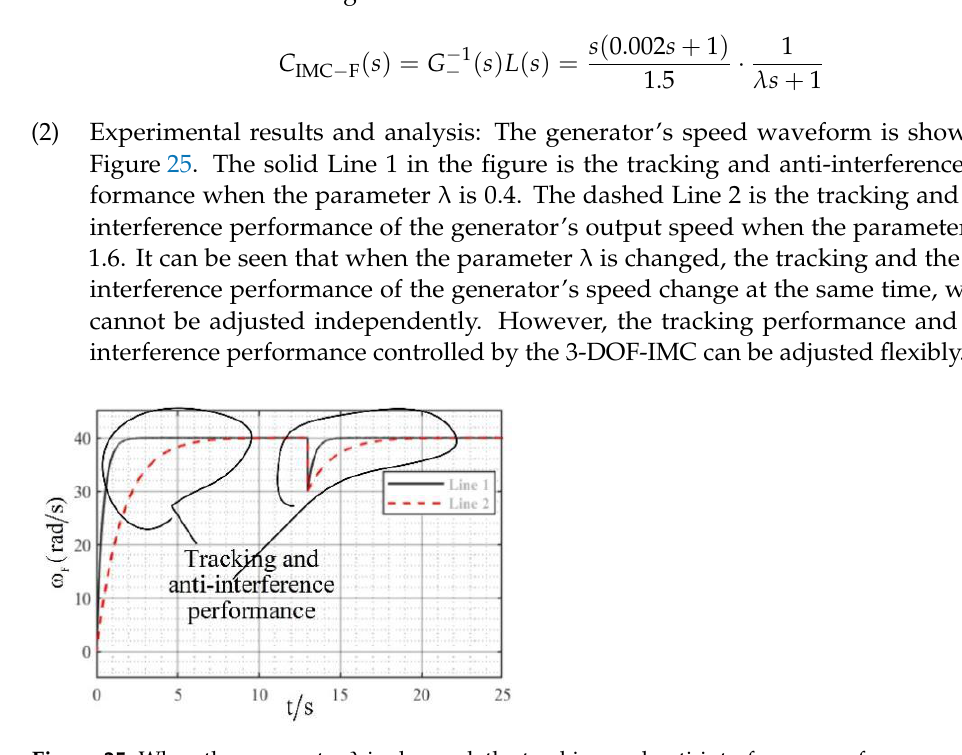
Figure 25. When the parameter λ is changed, the tracking and anti-interference performance of the generator’s speed based on 1 -DOF-IMC.